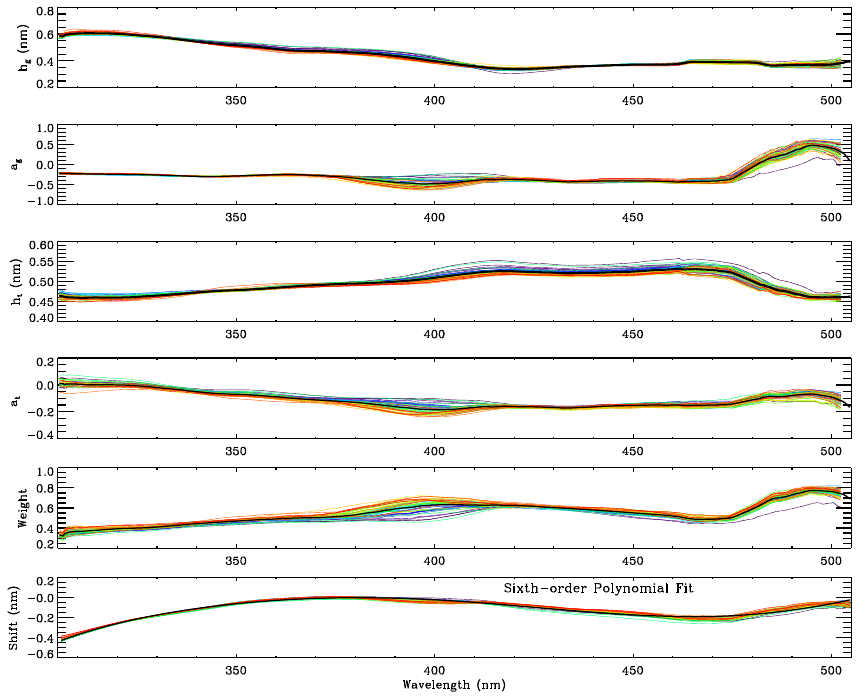
Figure 5. Derived asymmetric Gaussian slit half-width at 1 /e intensity ( h g ) , asymmetry factor ( a g ) , asymmetric top-hat slit half-width at 1 /e intensity ( h t ) and asymmetric factor ( a t ) , the fraction of top-hat slit function, and wavelength shift from the initial wavelength assignment as functions of wavelength in the ACAM air-quality channel using 53 ACAM ground pixels on 21 July 2011. Different colors are for different ACAM pixels; the black lines are the average parameters (slit parameters) or a sixth-order polynomial fit (wavelength shift). The slit parameters and wavelength shifts are derived over a range of 201 ACAM pixels ( ∼ 20nm) in 3-pixel increments sliding through the channel. The derived parameters at a wavelength are the average of these parameters in all windows including this